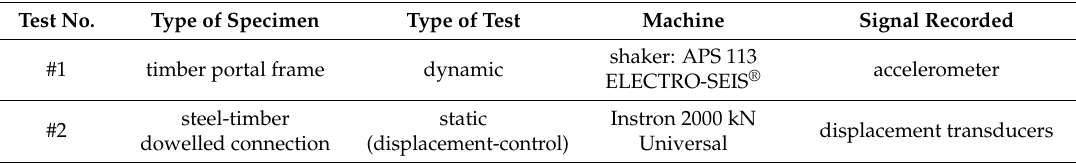
Table 1. Summary of the experimental tests performed in laboratory.